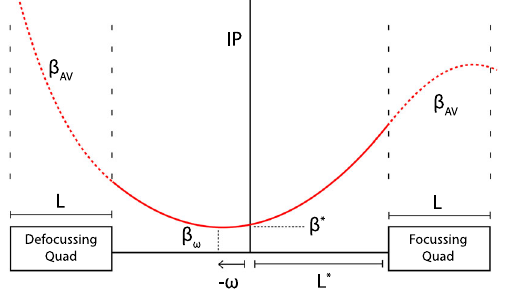
FIG. 1. Schematic representation of interaction region configu- ration. This corresponds to the default horizontal plane as defined in MAD - X models of the LHC, with a focusing quadrupole on the right and a defocusing quadrupole on the left. FIG. 2. Schematic representation of the closest tune approach. The unperturbed tunes are labeled as Q x and Q y , while the perturbed tunes are given by Q 1 and Q 2